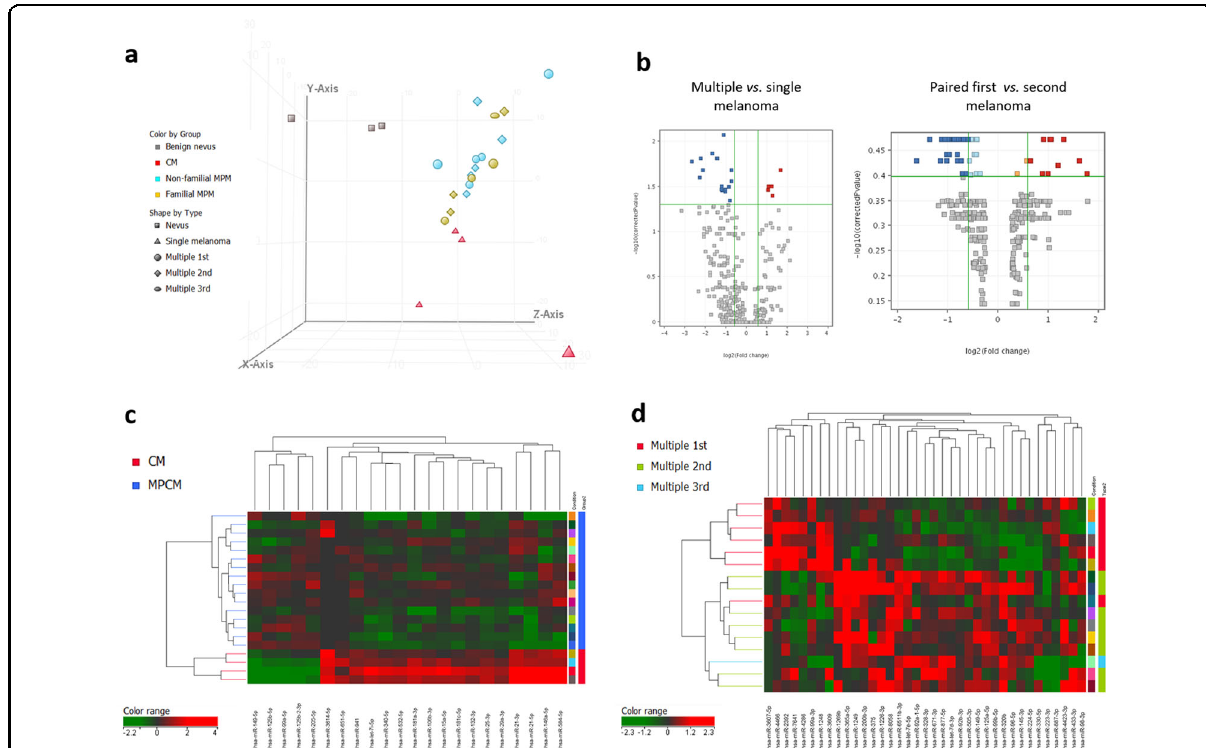
Fig. 1 Single and multiple melanoma classi fi cation based on the miRNA pro fi le. a Unsupervised principal component analysis (PCA) of 24 samples based on the expression pro fi le of all the miRNAs detected at NGS analysis. Familial (yellow) and non-familial (cyan) multiple primary melanomas display a similar microRNA pro fi le, which is different from single cutaneous melanoma (red) and benign nevi (gray). b Cluster analysis and heatmap representation of multiple and single melanoma based on the expression of 22 differentially expressed miRNAs (moderated t -test, adjusted p < 0.05). Red and green color represent the increased or reduced expression across samples. c Cluster analysis and heatmap representation of the fi rst and second melanomas from the same patient based on the expression of 37 differentially expressed miRNAs (paired t -test, p < 0.05). Red and green color represent the increased or reduced expression across samples. d Volcano plot showing the differentially expressed miRNAs at the selected p -value and fold-change